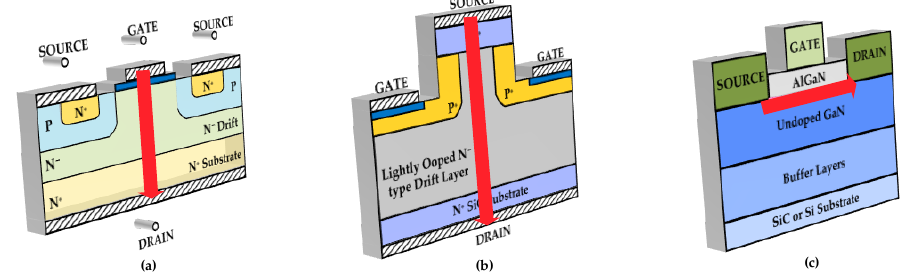
Figure 4. The structures of ( a ) Si MOSFET, ( b ) SiC MOSFET, and ( c ) GaN HEMT. [46] Adapted from [46,47].